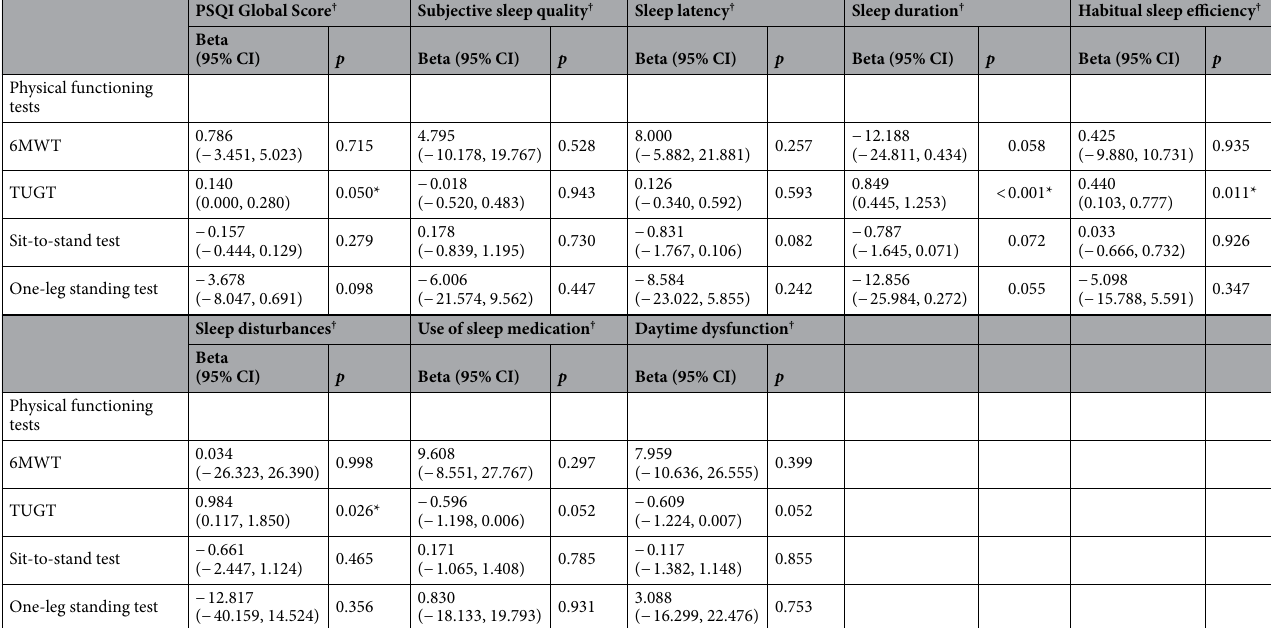
Table 3. Multivariable regression model for subjective sleep measures with physical performance. * p < 0.05. † Adjusted for age, gender, BMI, education level, time since diagnosis, current treatment, marital status,